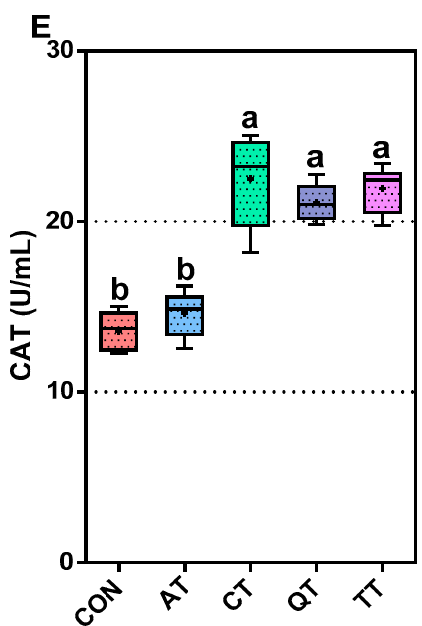
Figure 1. Effects of adding different tannins to the diet on the antioxidant capacity of broilers. ( A ) Total antioxidant capacity, T-AOC; ( B ) malondialdehyde, MDA; ( C ) super oxide dimutese, SOD; ( D ) glutathione peroxidase, GSH-Px; ( E ) catalase, CAT. Different letters (a, b, c and d) indicate significant differences ( p < 0.05), while the same letter indicates no significant differences ( p > 0.05). CON, control; AT, Acacia mearnsii tannin; CT, Castanea sativa tannin; QT, Schinopsis lorenzii tannin; TT, Caesalpinia spinosa tannin.